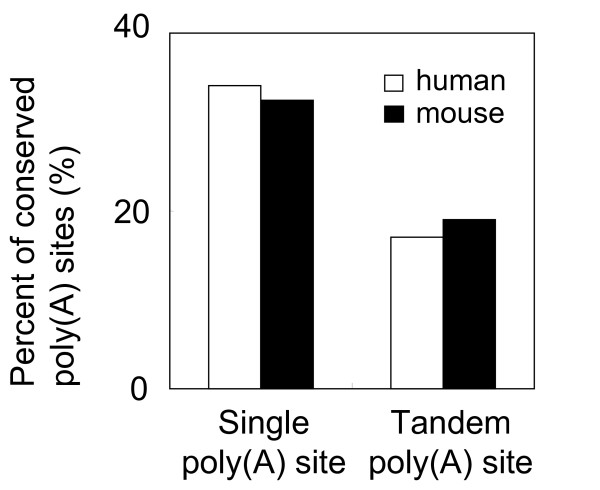
Proportion of conserved sites among single sites and among tandem sites, in human and mouse.